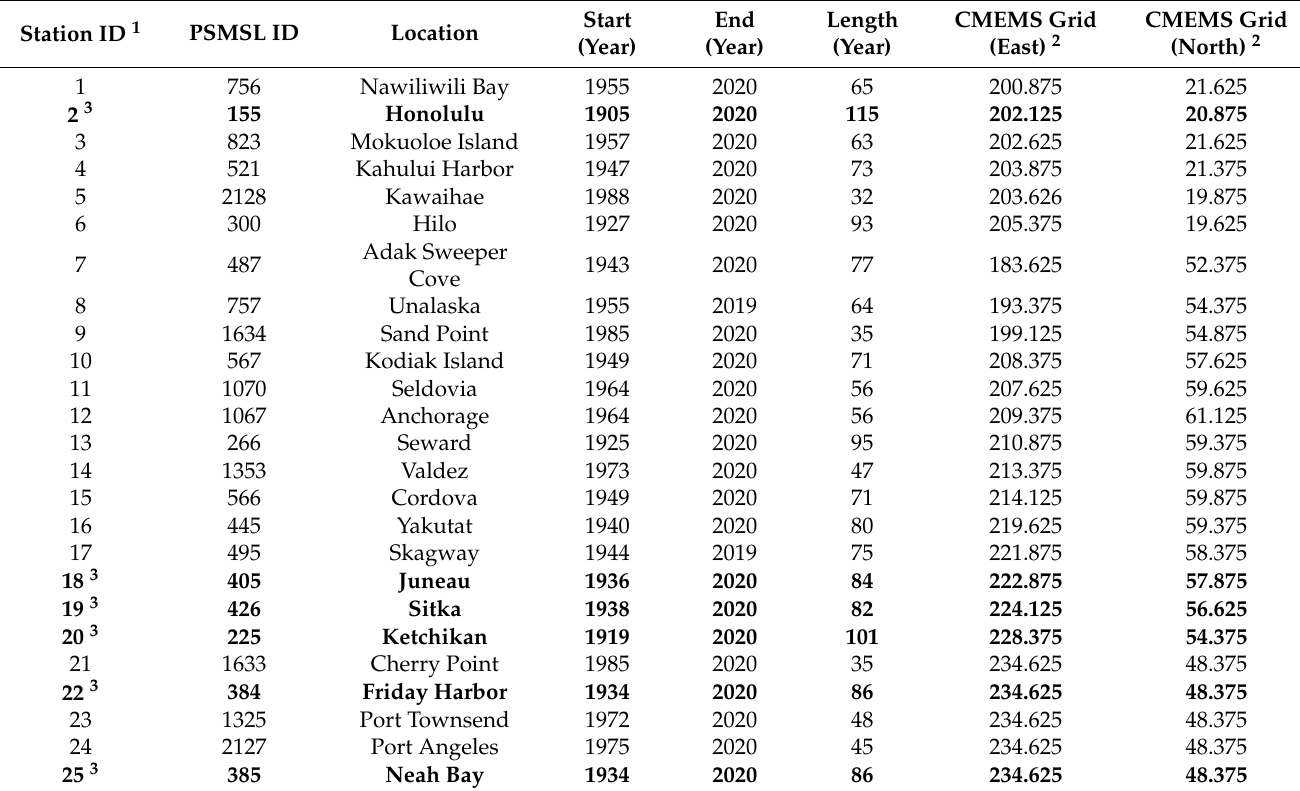
Figure 1. Location of tide gauge records analysed for this study. Full details of data records are summarised in Table 1. Table 1. Summary of tide gauge and satellite altimeter data used in this study.